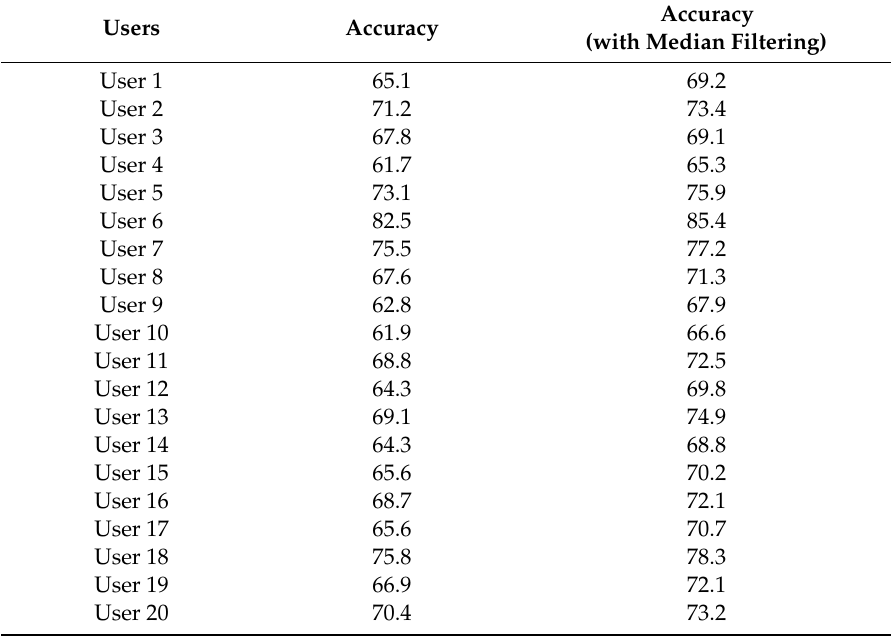
Table 5. “One-subject-out” prediction accuracies for DEAP dataset using two-classes